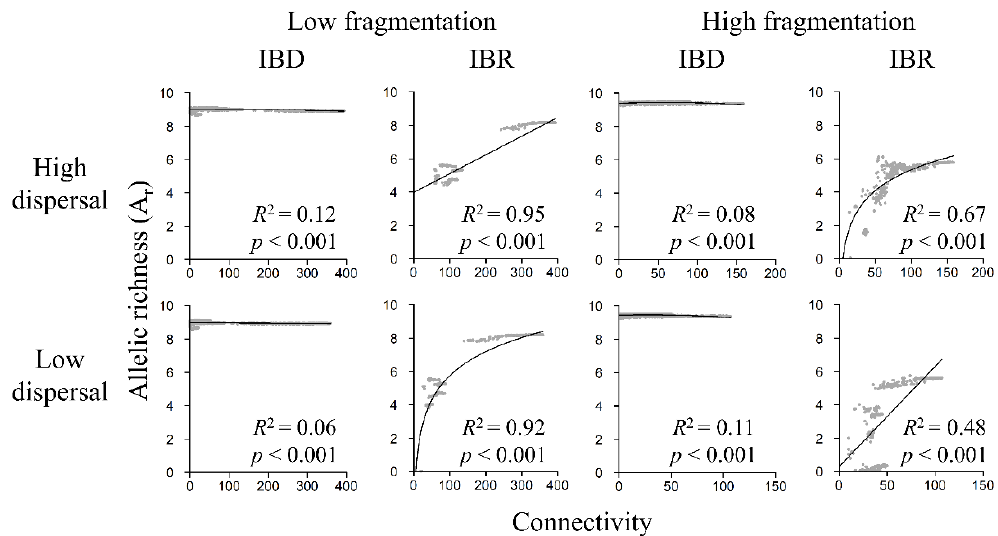
Figure 8. Relationship between A r and landscape connectivity in the low-fragmentation model (left two columns) and the high-fragmentation model (right two columns). Top row: high-dispersal scenario (300 km). Bottom row: low-dispersal scenario (200 km). Allelic richness (y-axis) is calculated with software sGD. Connectivity (x-axis) is quantified in terms of cumulative resistant kernel density, representing the expected density of dispersing individuals. Gray markers represent the mean of 100 Monte Carlo simulation runs for each node. Adjusted R 2 and p -value are